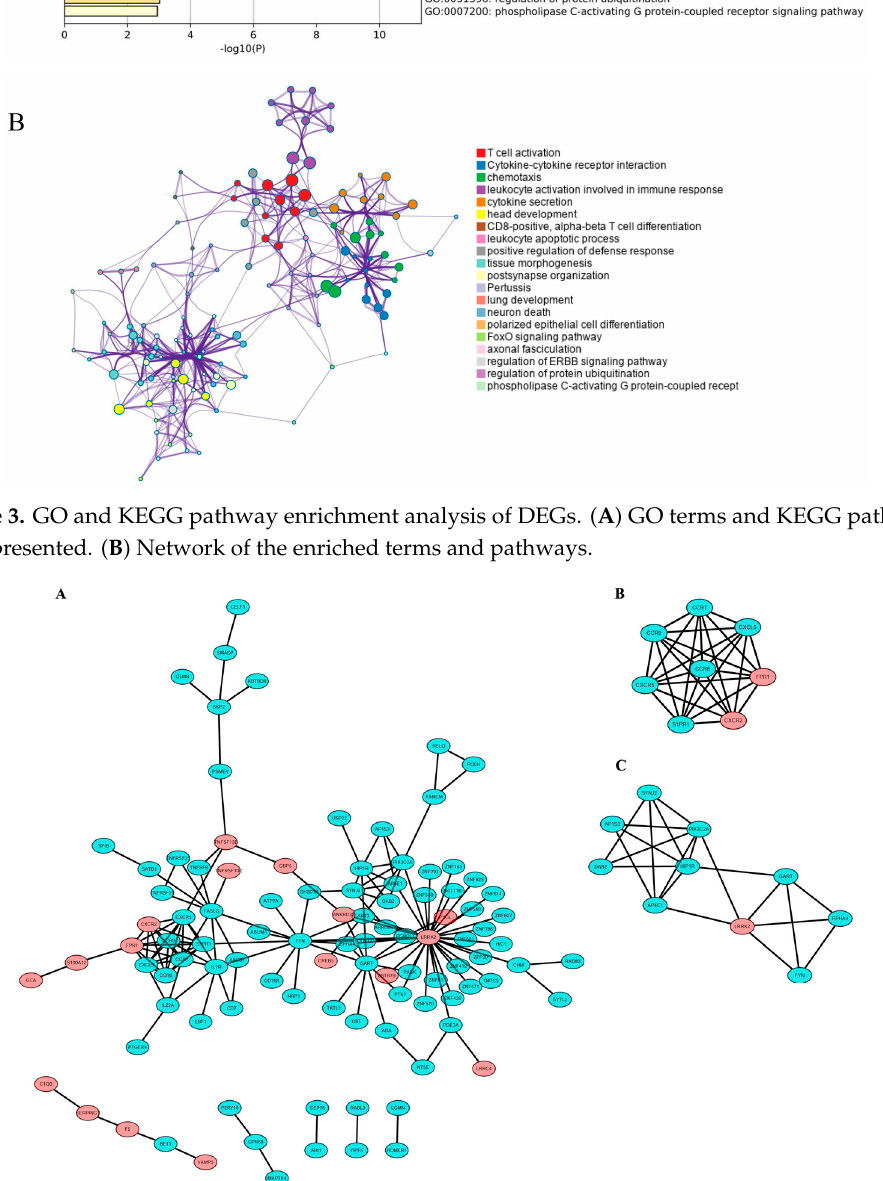
Figure 5. Heat map of top 6 hub genes’ expression in both ( A ) GSE62525 and ( B ) GSE54992. Blue represents downregulation, and red represents upregulation. 3.4. Module Analysis To understand the potential function of genes in modules at the molecular level, we used MCODE plugin to analyze the module of the PPI network, and chose the most significant two modules for further analyses according to the degree of importance. The PPI network of DEGs is illustrated in Figure 5A and top two modules are shown in Figures 5B.